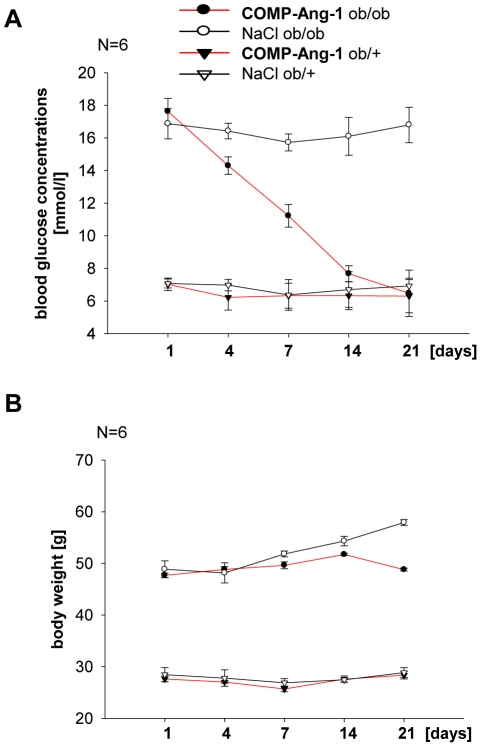
Effect of COMP-Ang-1 treatment on blood glucose concentrations and body weight.Metabolic parameters and body weight of ob/ob mice and non-diabetic ob/+ control mice with COMP-Ang-1 (100 ng/ml) or NaCl treatment. COMP-Ang-1 significantly decreased blood glucose level (A) in ob/ob mice compared with NaCl treatment at 21 days. After 21 days, glucose concentration was indistinguishable between COMP-Ang1 treated ob/ob and non-diabetic ob/+ mice. (B) Effect of COMP-Ang-1 treatment of body weight. Data are means ±SD; n = 6 per group.